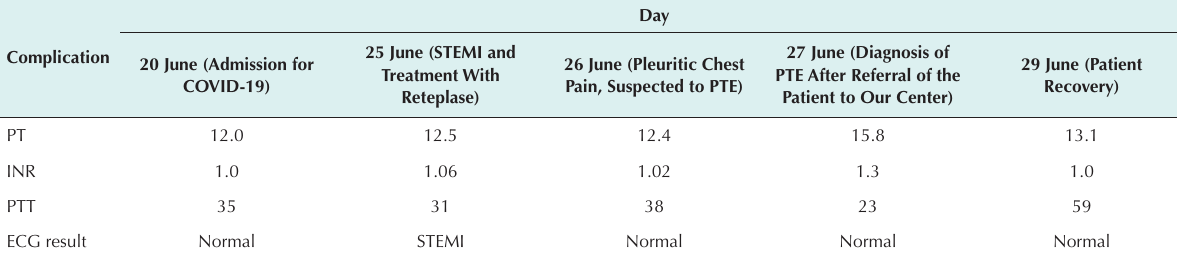
Table 1 . Serial Coagulation Tests and ECG Results of the Patient